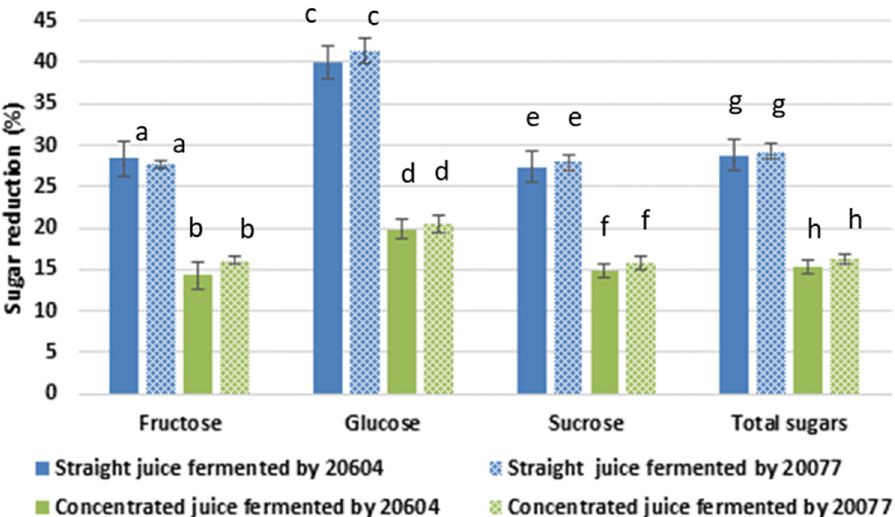
Figure 1. The extent of individual and total sugars reduction (%) in the fermented carrot juices by two Lactobacillus gasseri strains (strain DSM 20604 and strain DSM 20077) compared to non-fermented juices. Different letters within a group indicate significant difference ( p < 0.05).